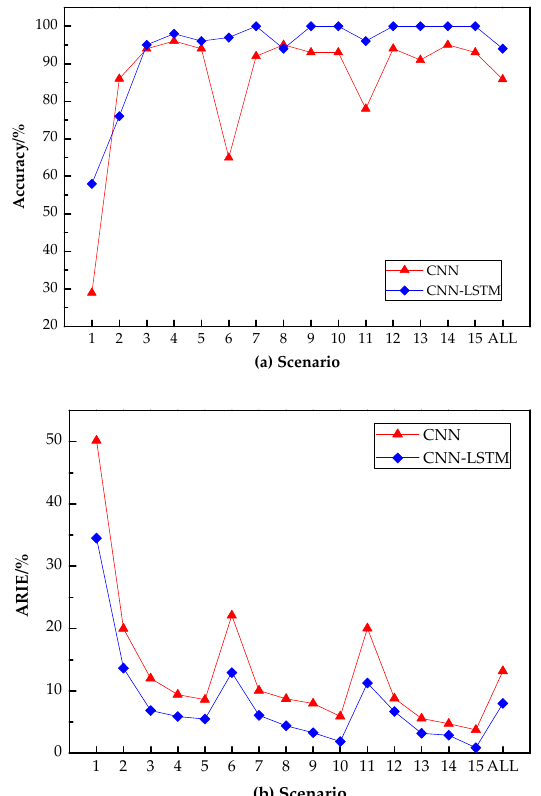
Figure 13. Performance comparison: ( a ) Damage localization; ( b ) Damage severity prediction.